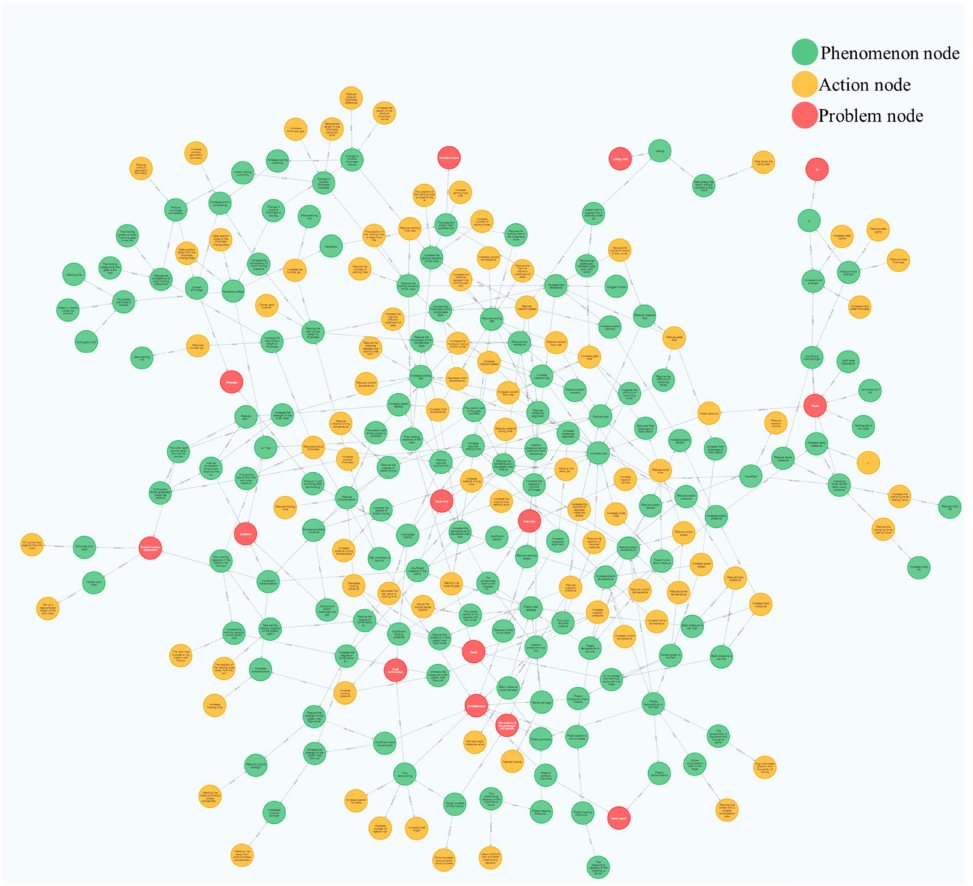
Figure 4. Injection molding knowledge